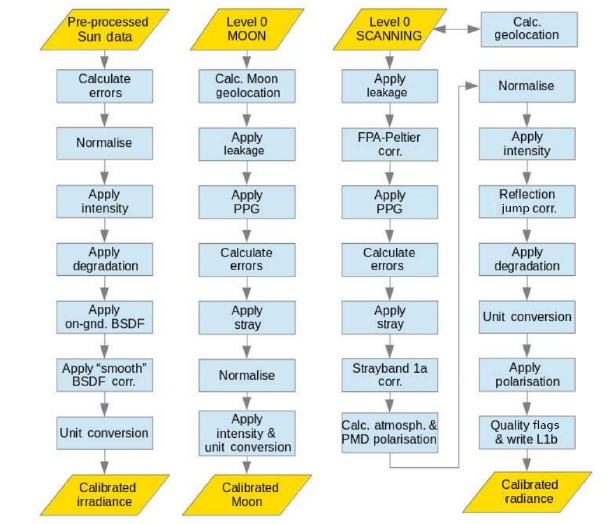
Figure 2. Processing flow for calculating the in-flight calibration parameters from the dark signal measurements (DARK), the in- ternal LED measurements (LED), the spectral lamp measurements (LAMP), and the solar measurements (SUN). The calibration pa- rameters as well as the Sun mean reference (SMR) spectrum are stored in the calibration database.